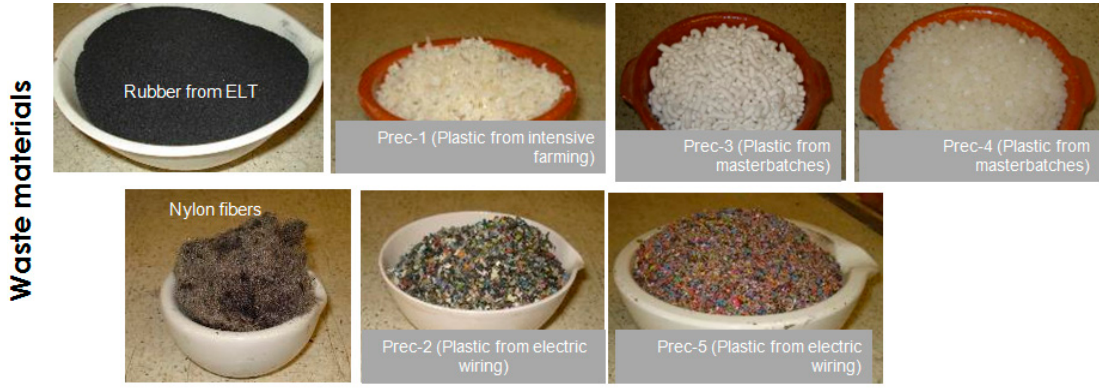
Figure 5. Materials used for generating the additives for asphalt mixes.